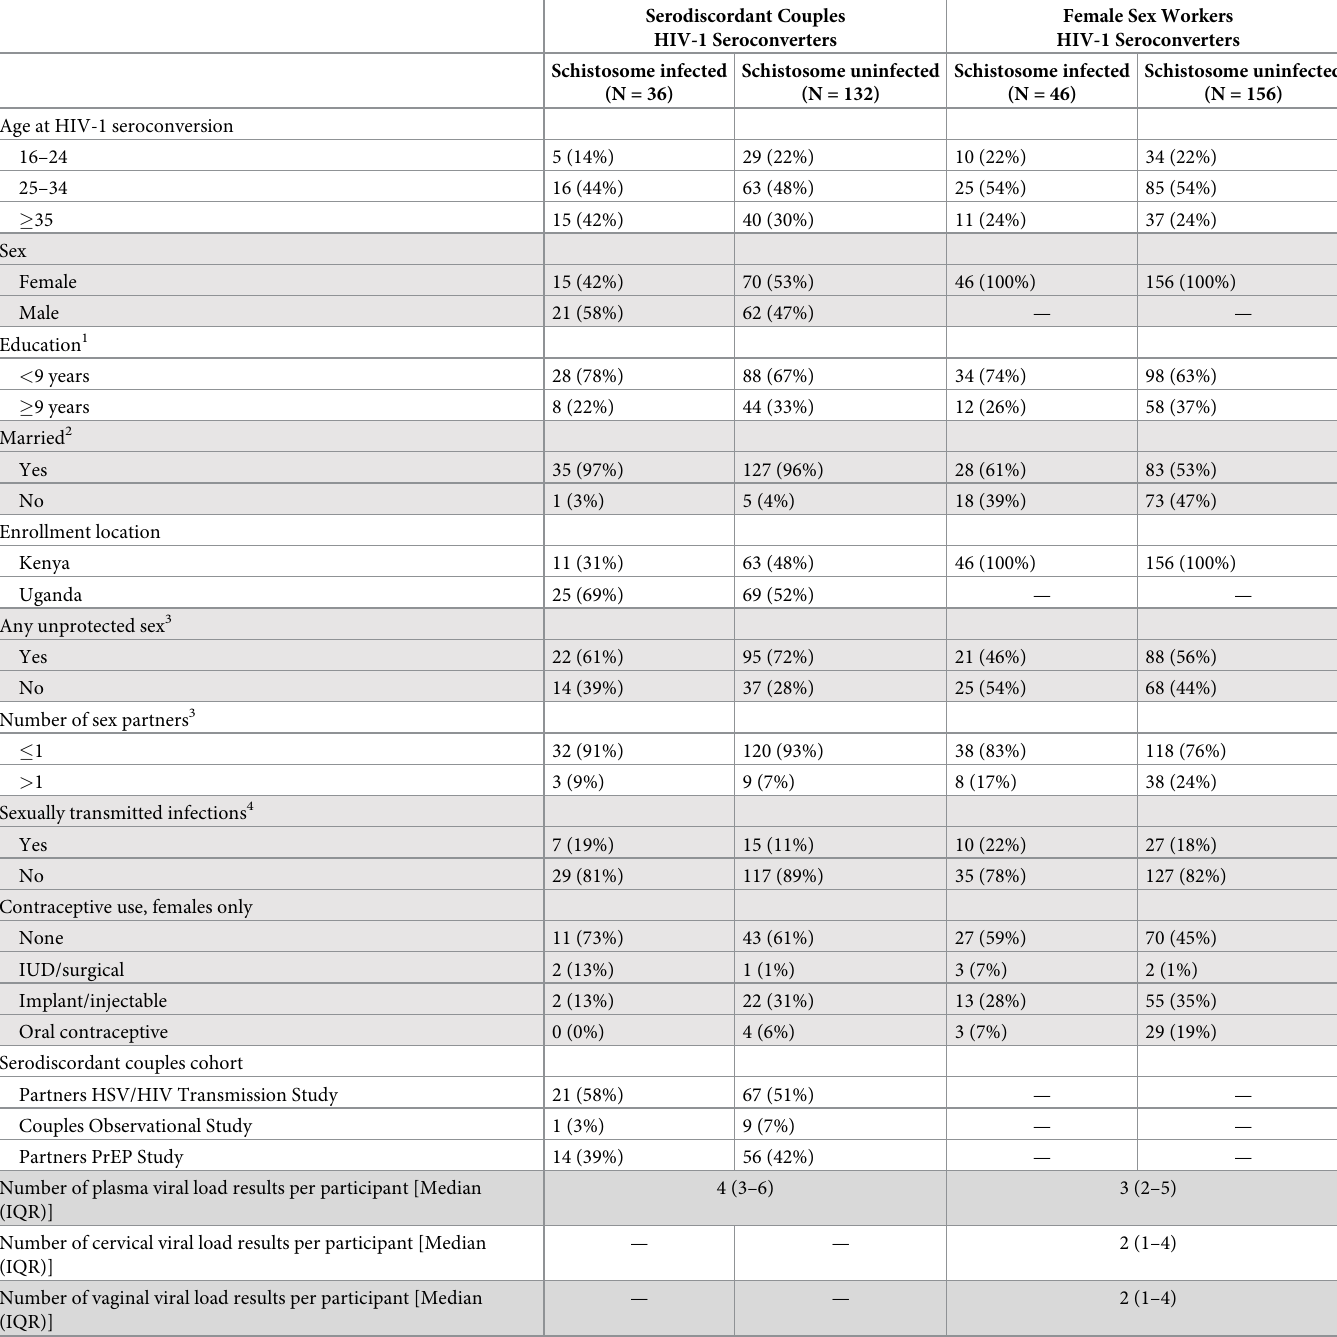
Table 1. Characteristics of participants with eligible set point viral load results after HIV-1